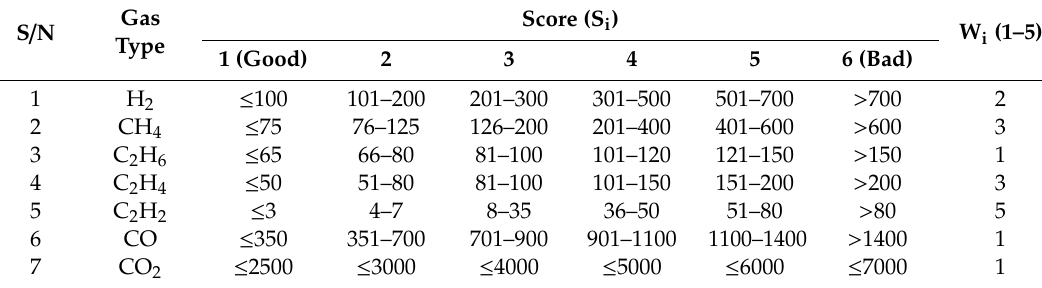
Table A3. Scoring and weighting factors for DGA